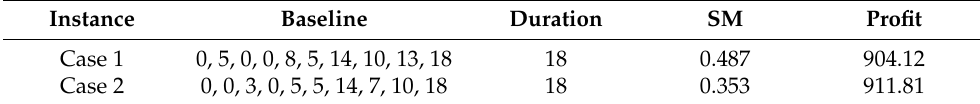
Table 7. Objective function values for two test